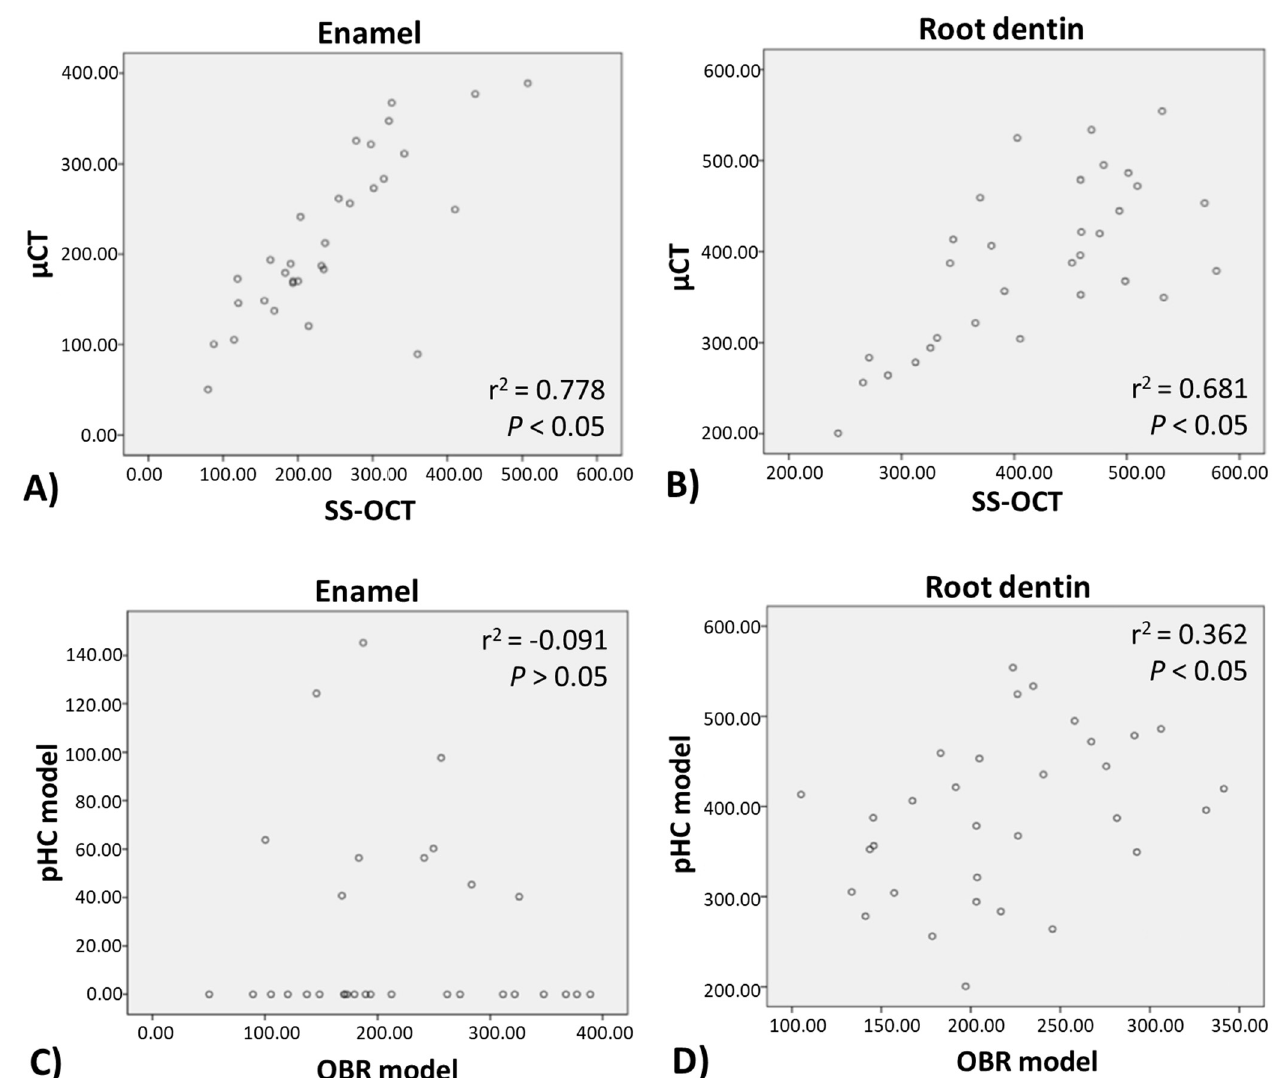
Figure 6. Pearson correlation coefficient analysis between the two evaluation methods ( µ CT and SS-OCT) and the two artificial caries models (pHC and OBR). The lesion depth measured from SS-OCT and µ CT showed significant correlation ( p < 0.05) for both ( A ) enamel and ( B ) root dentin. For artificial caries generated model, Pearson correlation coefficient showed no relationship between pHC and OBR model at ( C ) enamel region ( r 2 = − 0.091, p > 0.05), but positive correlation at ( D ) the root dentin region ( p < 0.05).